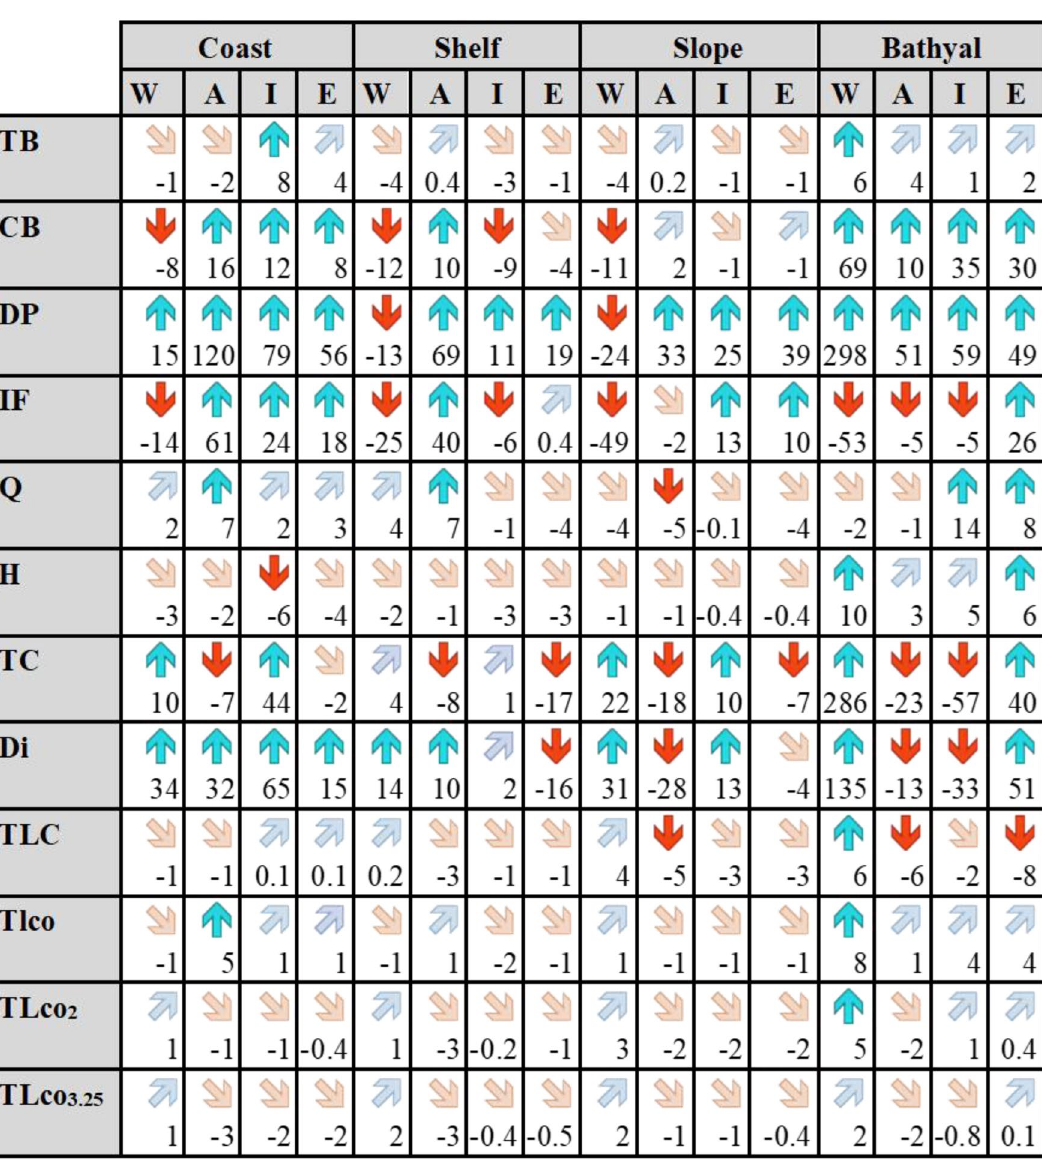
Table 1. Relative mean change (%) per assessed indicator ( TB Total biomass, CB commercial biomass, DP Demersal/Pelagic fish, IF Invertebrates/Fish, Q Kempton index, H Shannon index, TC total catch, Di discards, TLC trophic level (TL) of the catch, TLco trophic level (TL) of species/Fg in the community, TLco2 trophic level (TL) in the community with TL ≥ 2; Trophic level (TL) in the community with TL ≥ 3.25) divided per MSFD sub-region ( W Western, A Adriatic, I Ionian, E Eastern) and per bathymetric feature (Coast: 0–50 m; Shelf: 51–200 m; Slope: 201–800 m; Bathyal: > 800 m). Red arrow represents mean change < − 5%; pink arrow between − 5% and 0; blue arrow > 5%; light blue between 0 and